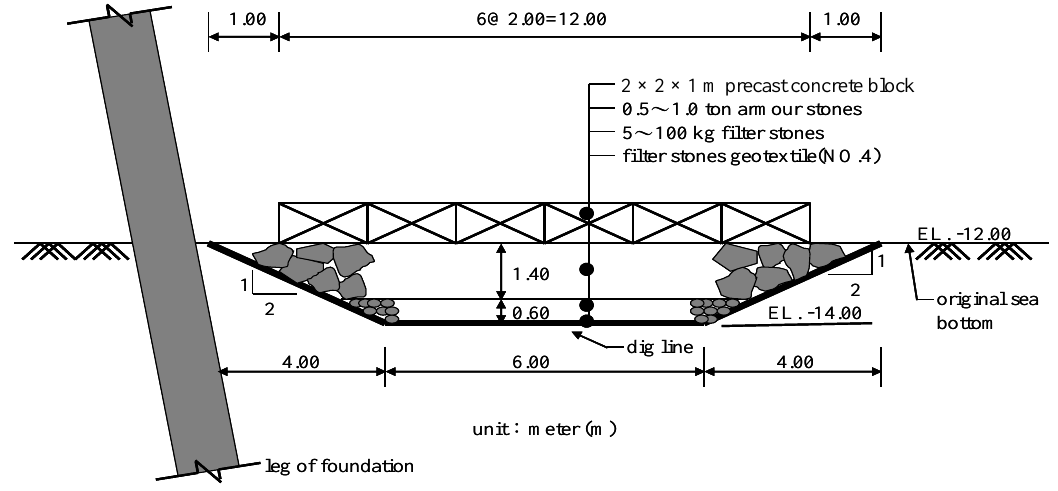
Figure 5. A sketch of the proposed hard scour protection for the jacket-type foundation.